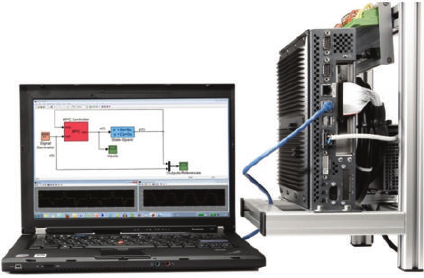
Figure 14: Hardware setup for rapid prototyping of a model predictive controller on PC-compatible hardware using Simulink Coder and xPC Target